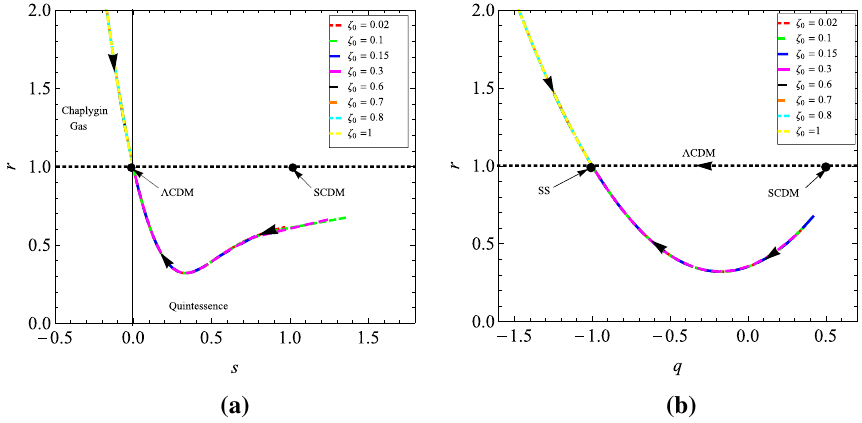
Fig. 3 a The r − s trajectories are plotted in r − s plane for different values of ζ 0 > 0 with ω d = − 0 . 5, α = 0 . 8502 and β = 0 . 4817. The arrows represent the directions of the evolutions of statefinder diagnos- tic pair with time. The curves are coinciding with each other for smaller and larger values of ζ 0 . b The r − q trajectories are plotted in r − q